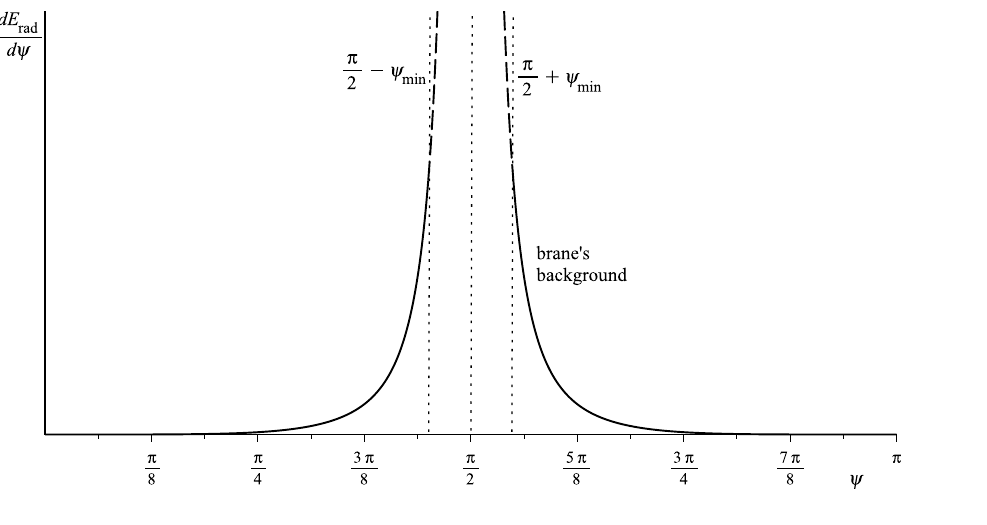
Figure 4 . Angular distribution of the emitted radiation at zero-speed for D =